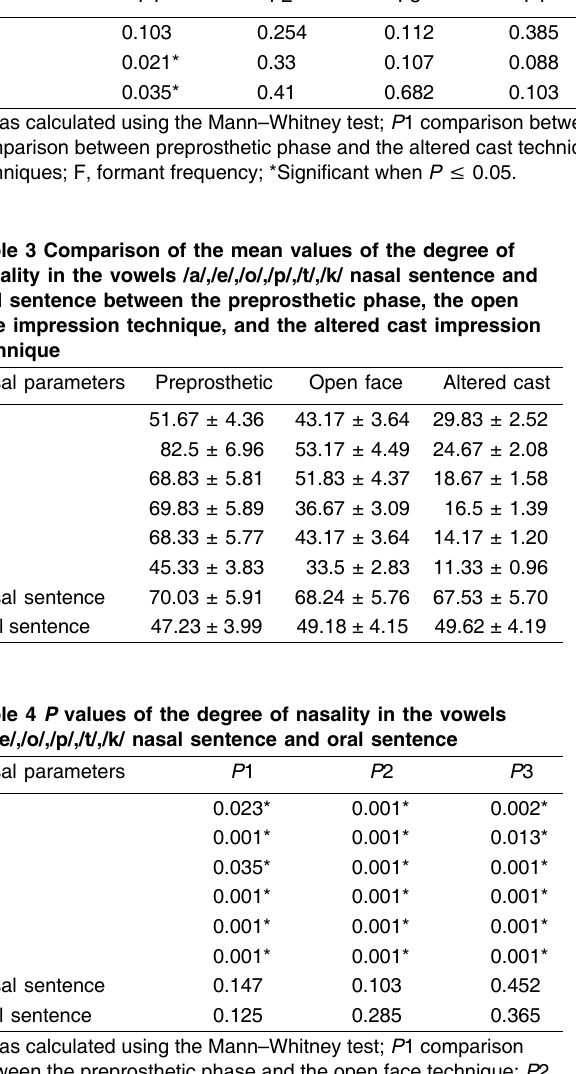
Table 2 P values for the (cid:383) rst three formant frequencies (F1, F2, and F3) of the vowels /a/,/e/,/o/ Vowels